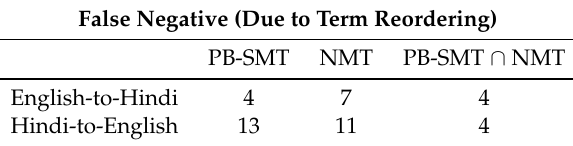
Table 8. False negatives in PB-SMT and NMT tasks when TermEval failed to distinguish reordered correct term translation. False Negative (Due to Term